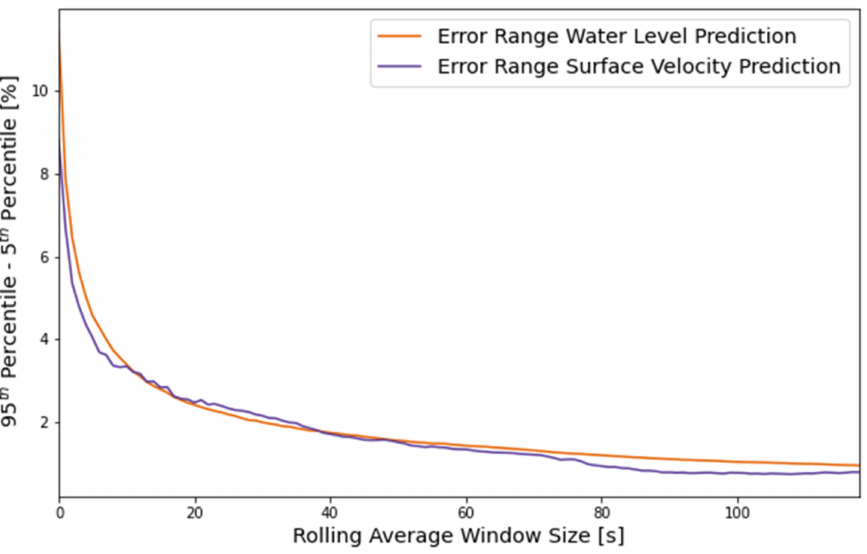
Figure 6. Influence of the prediction frequency on the error ranges of both the water level and the surface velocity